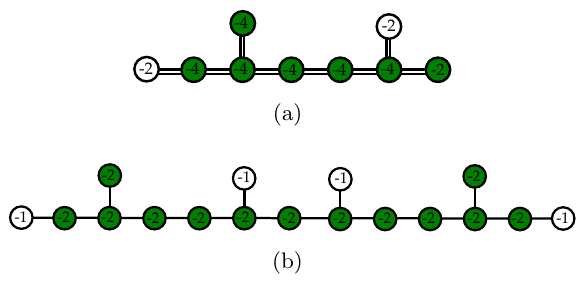
Figure 14 . (a) The ‘doubled’ CFD of the marginal theory for SU(3) on a ( (cid:0) 1)-curve with 12 hypermultiplets, which contains a twisted a(cid:14)ne Dynkin diagram b A tw as they are obtained by folding of (b). The unfolded version of (cid:12)gure (a), which contains an a(cid:14)ne SO(24) Dynkin